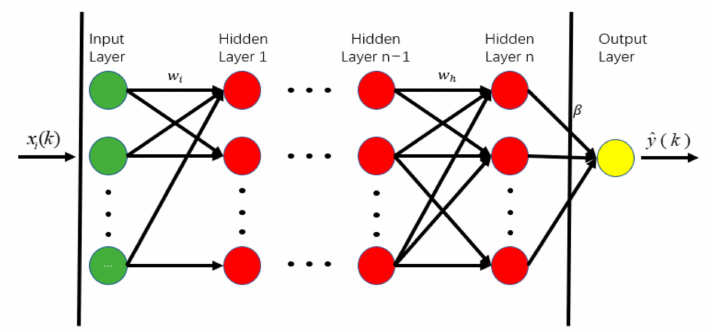
Figure 4. Structure of ANN model.